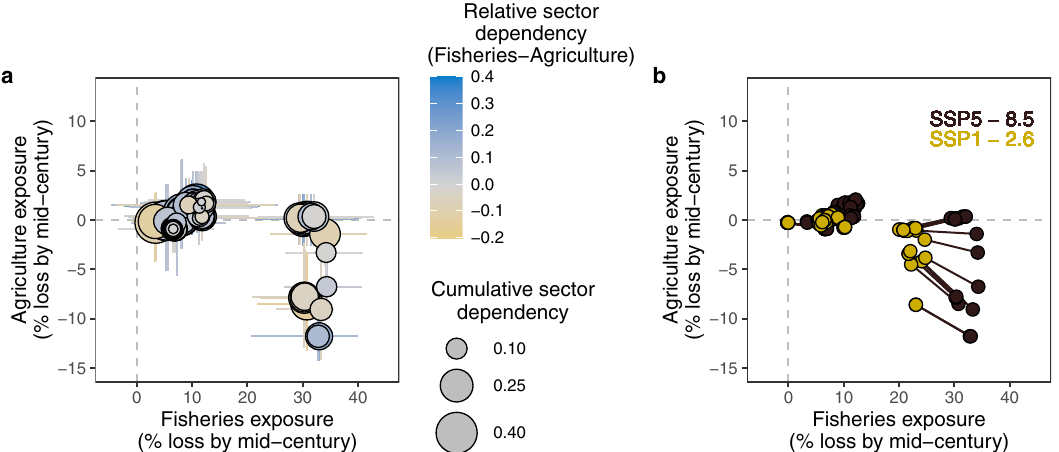
Fig. 3 Simultaneous potential losses to fi sheries and agriculture in coastal communities ( n = 72). a Under SSP5-8.5 agricultural losses (y-axis) plotted against fi sheries losses (x-axis), with bubble size revealing the overall sensitivity and colour revealing the fi sheries-agricultural relative sector dependency of each community ’ s sensitivity. b Potential bene fi ts of mitigation shown by the potential losses for each community change going from the high emissions scenario (SSP5-8.5 in red) to a low emissions scenario (SSP1-2.6 in